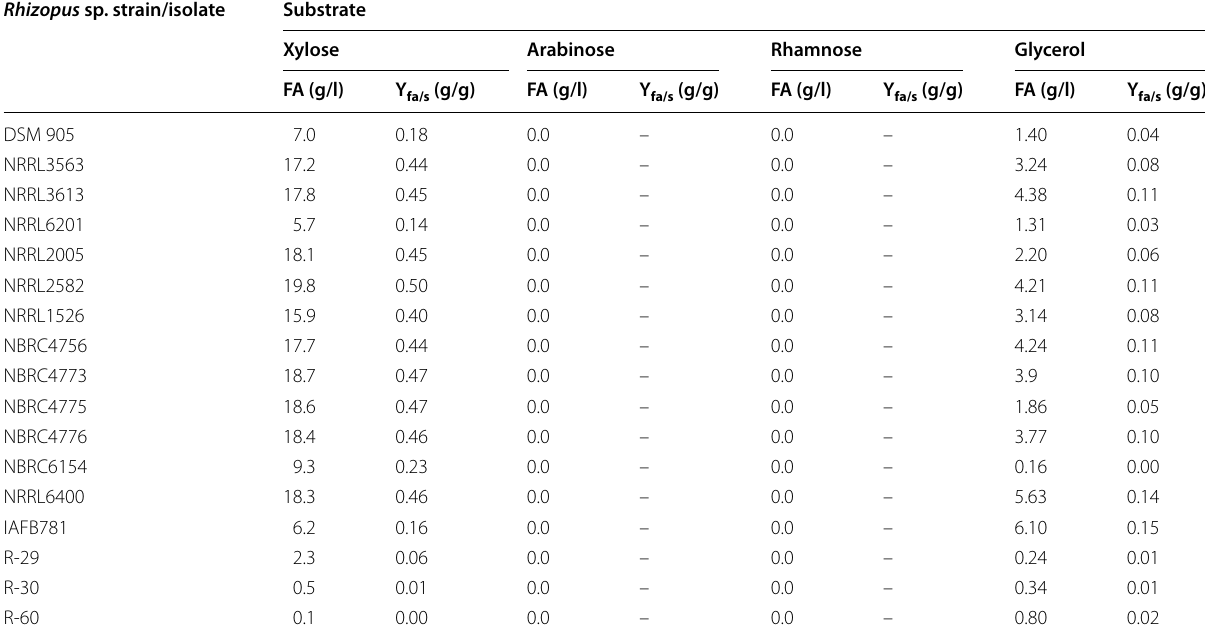
FA (g/l), fumaric acid concentration in medium after culture; Y fa/s (g/g), g of fumaric acid produced per g of carbon source consumed